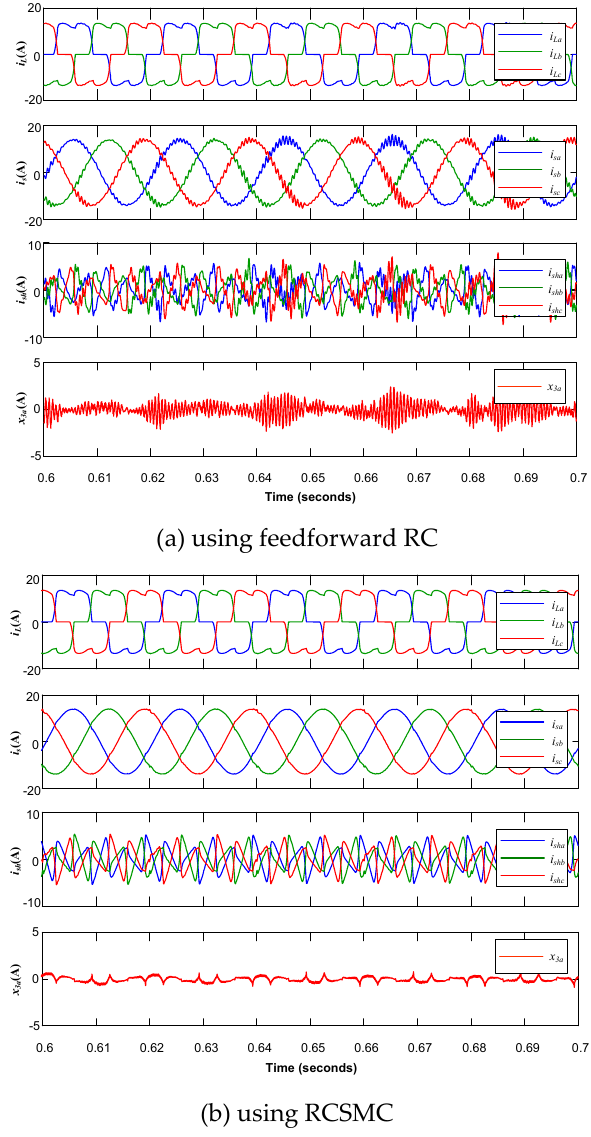
Figure 11. Simulation waveform of SAPF in steady state when the grid impedance changes.